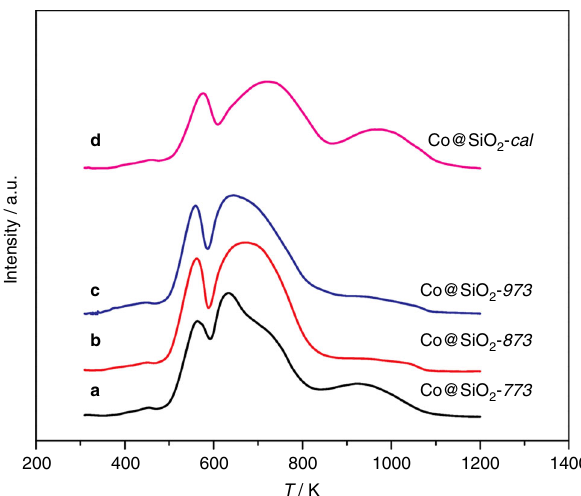
Fig. 3 TPR(H 2 ) pro fi les of Co@SiO 2 catalysts. a Co@SiO 2 - 773 , b Co@SiO 2 - 873 , c Co@SiO 973 , and d Co@SiO2- cal . The TPR(H 2 - 2 ) experiments were performed from 303 to 1223 K at a ramp of 5 K min − 1 in 10 vol.% H 2